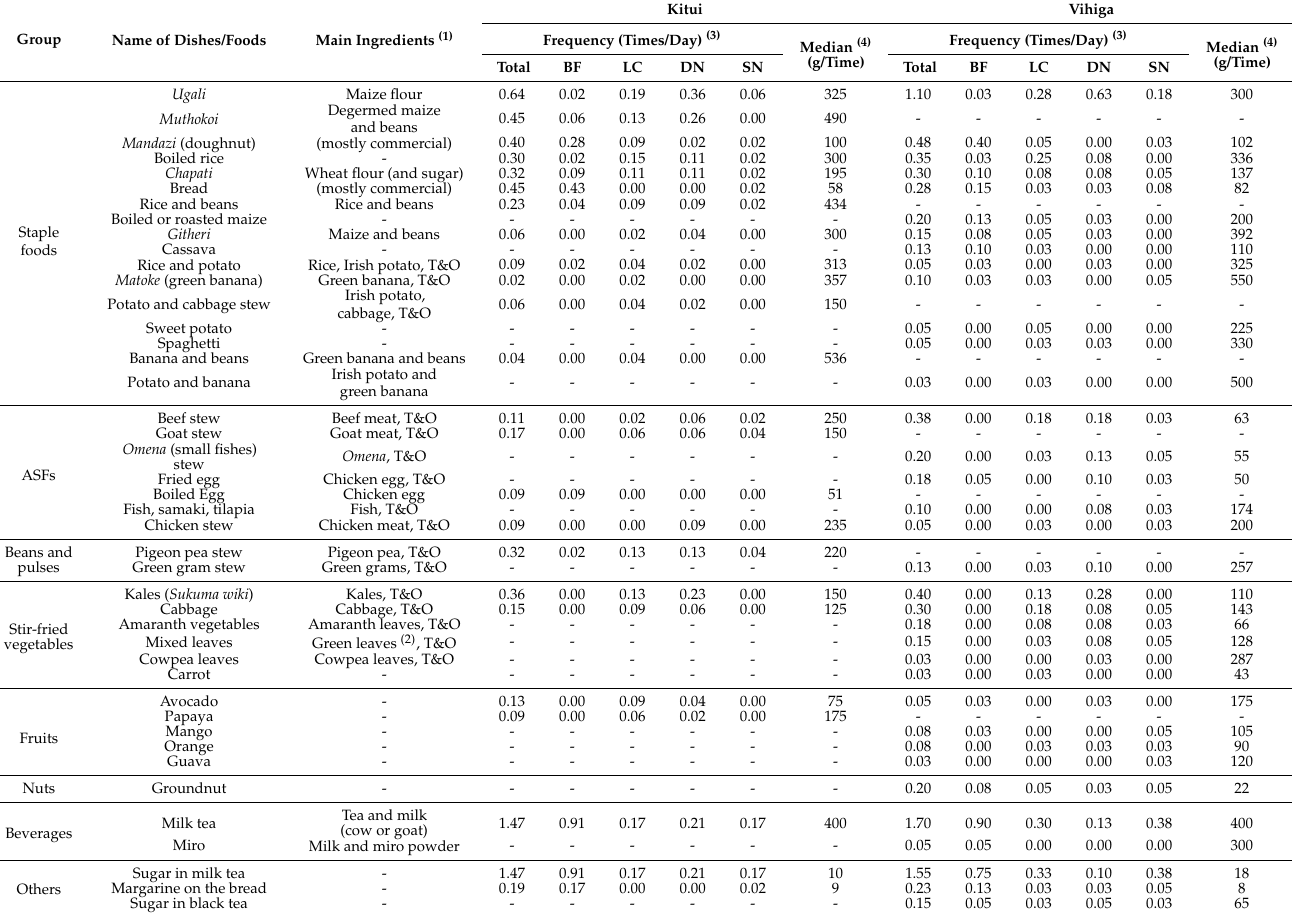
Figure 1. Average energy intake per time of day in farm women in charge of meal preparation (Kitui: 10 women, Vihiga: 11 women). Table 4. Frequency and median intake of each dish/food in farm women in charge of meal